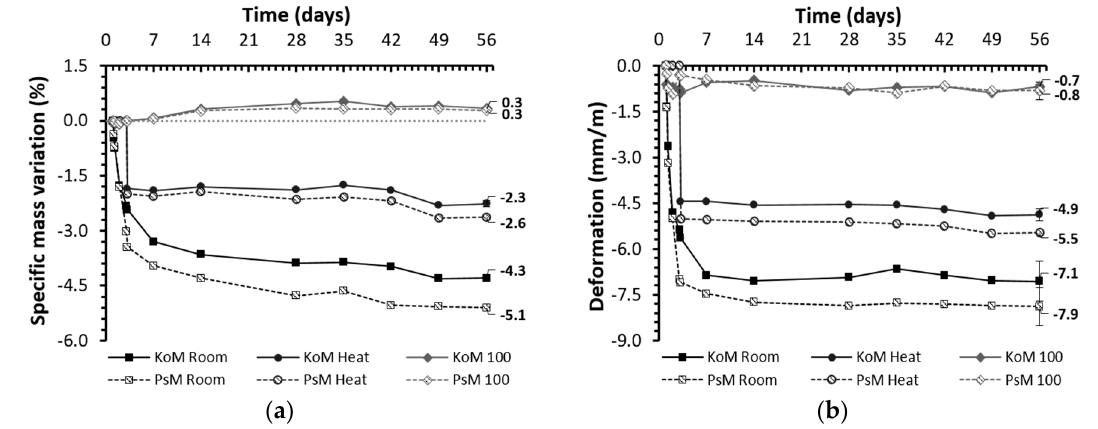
Figure 7. Specific mass variation ( a ) and total drying shrinkage ( b ) of alkali-activated mortars cured under different conditions.